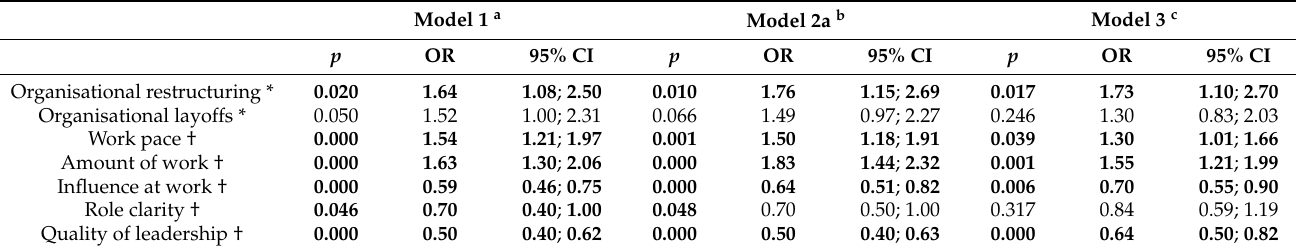
Bold numbers indicate significance level < 0.05. * Dichotomous measure: yes vs. no. † Scale: OR for each one-step increase in a scale score ranging from 0 to 4. a Each working condition unadjusted. b Additionally adjusted for occupational level only. c Additionally adjusted for baseline workplace bullying.